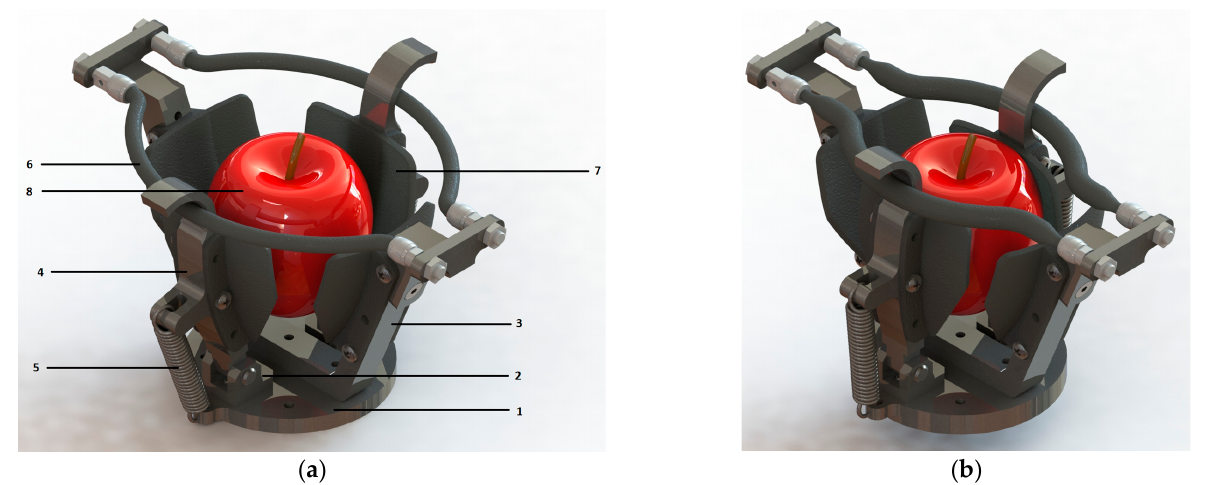
Figure 1. A 3D model for the proposed harvesting gripper in: ( a ) deactivated state, where: 1—base, 2—joint, 3—structural element for sustaining the actuators, 4—mobile connecting element, 5—elastic element (spring) in a compressed state, 6—Festo actuator DMSP-5-150N-RM-CM, 7—rubber part, 8—agricultural product to be harvested; ( b ) activated state.